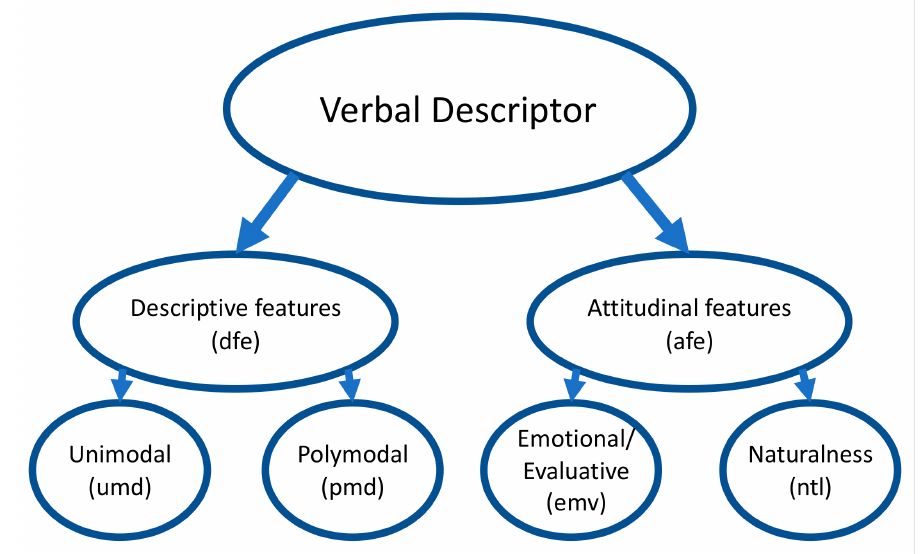
Figure 5. Verbal protocol analysis (VPA) Level 3 Features (after Samoylenko et al.